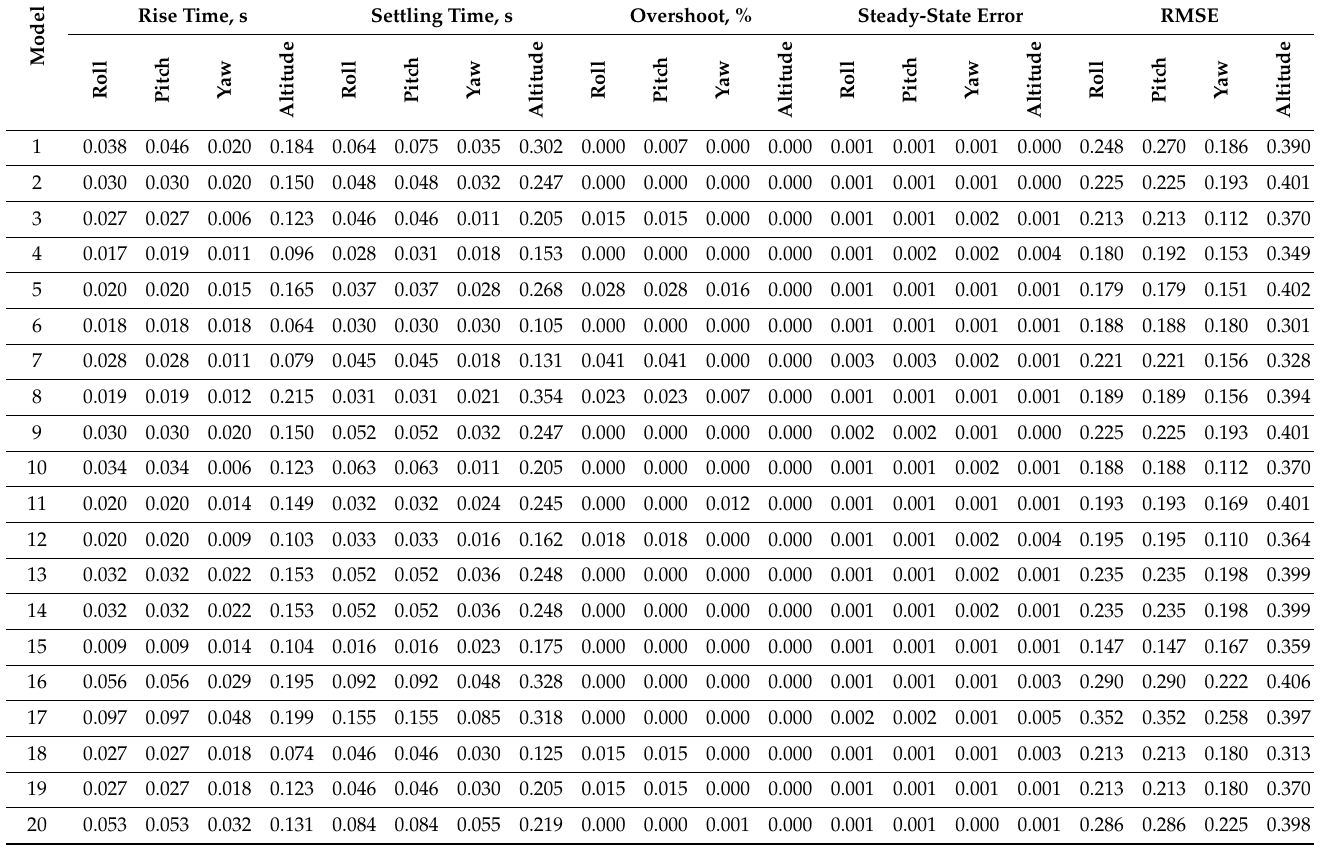
Table 5. Performance of the controller using 20 different quadrotor